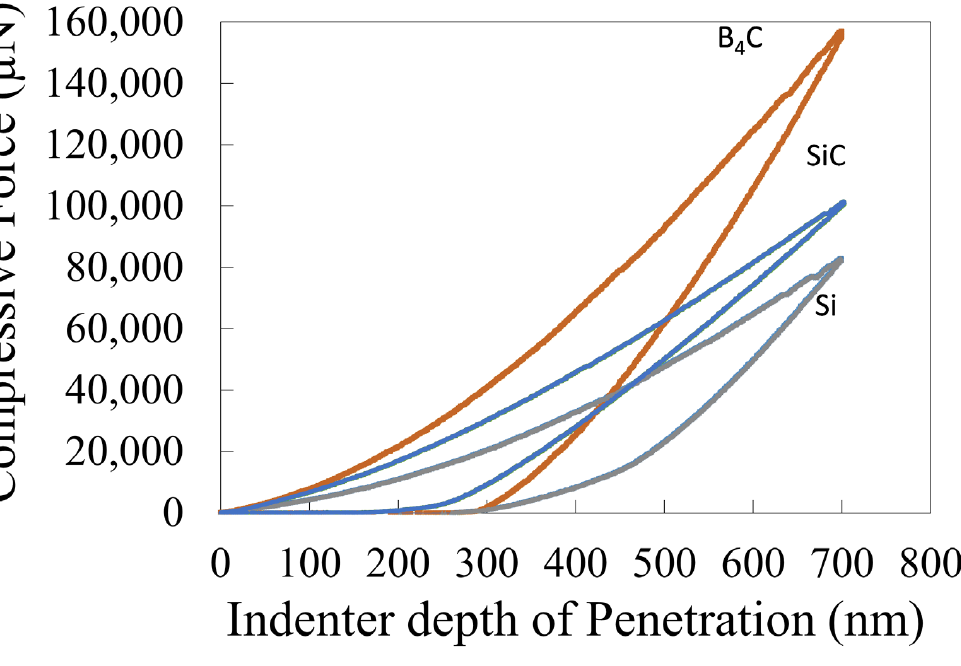
Figure 8. Berkovich indenter force versus displacement curve for each phase taken at the maximum